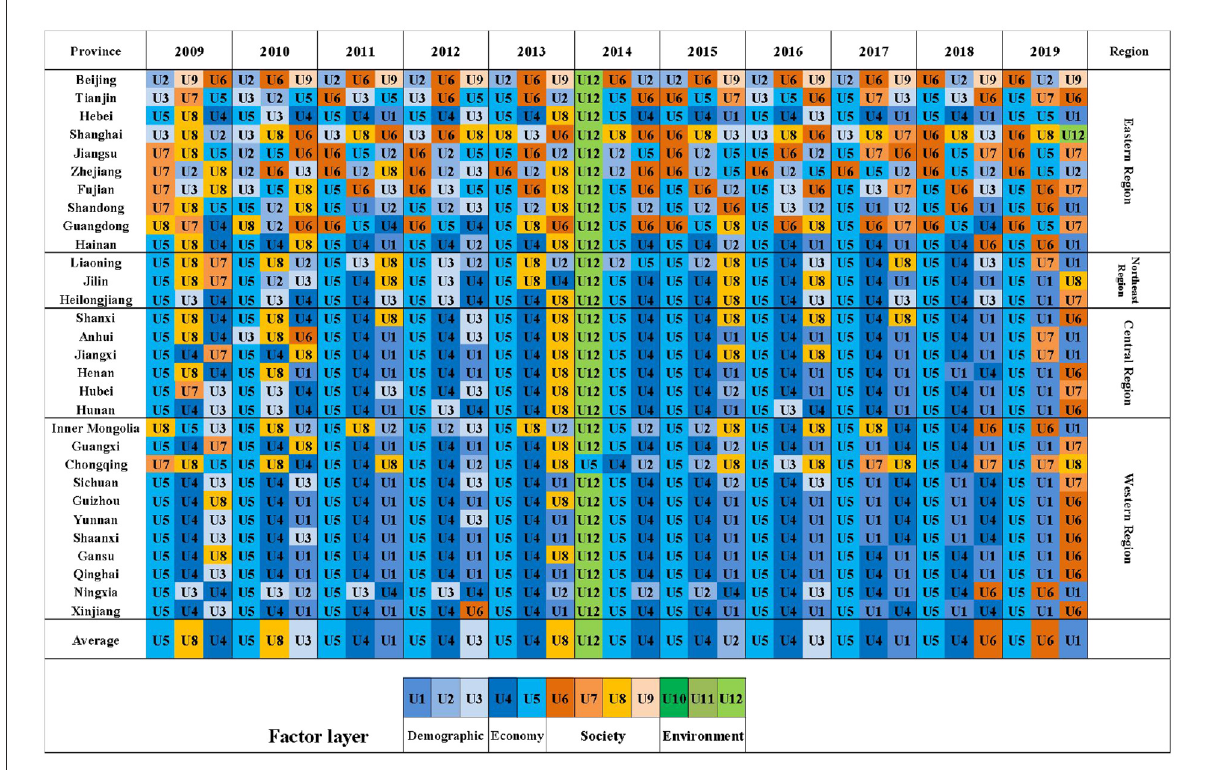
FIGURE11 Top three obstacle factors of NU subsystem in different regions, 2009–2019.